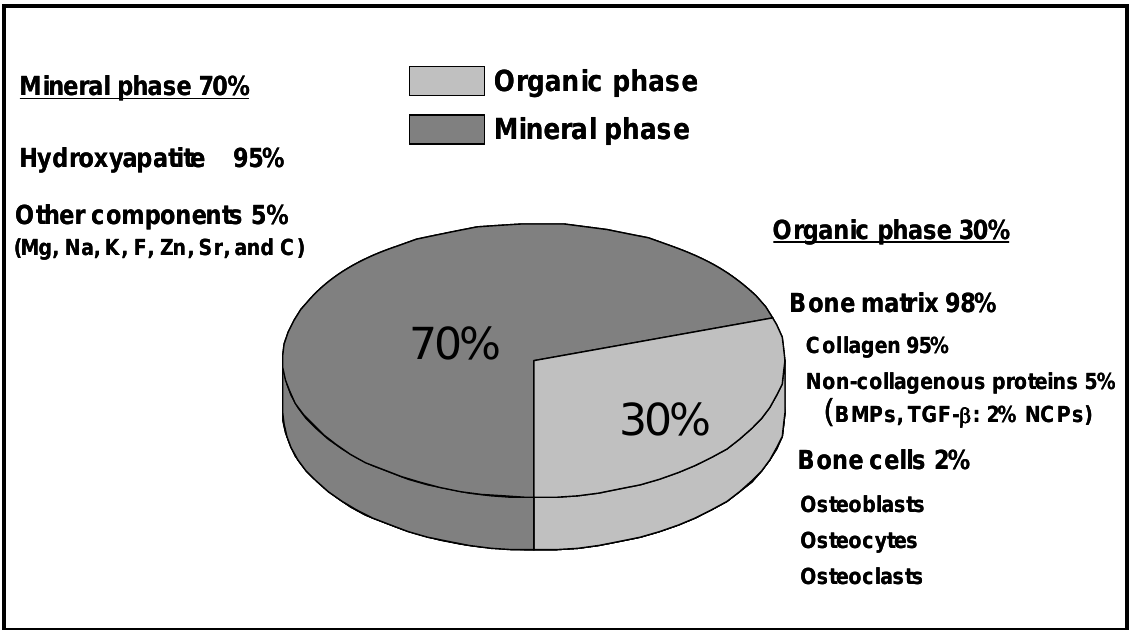
Figure 1. Chemical composition of bone